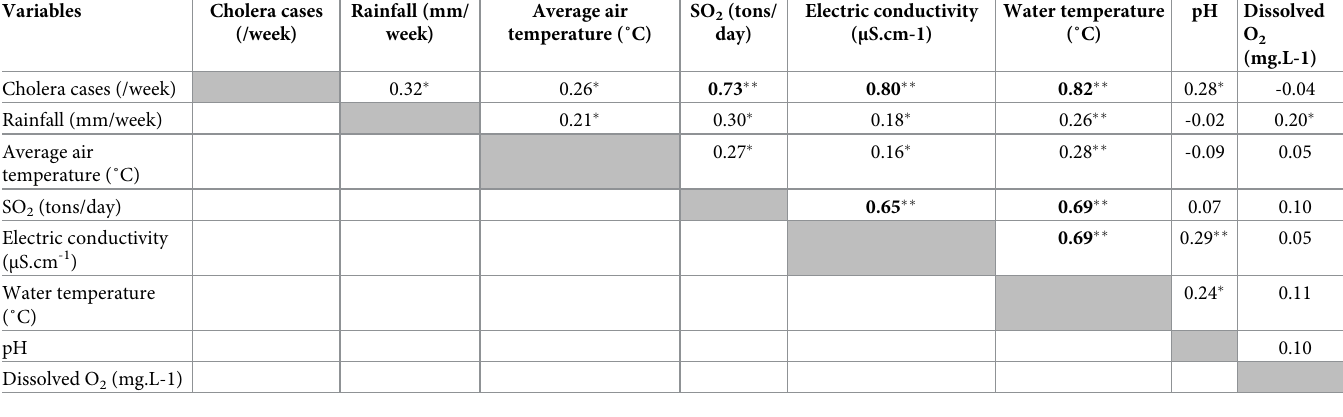
Table 2. Pearson correlation coefficients between logarithmic transformation of observed number of cholera cases and environmental variables over the 2007–2012 period (n = 147 sampled dates).